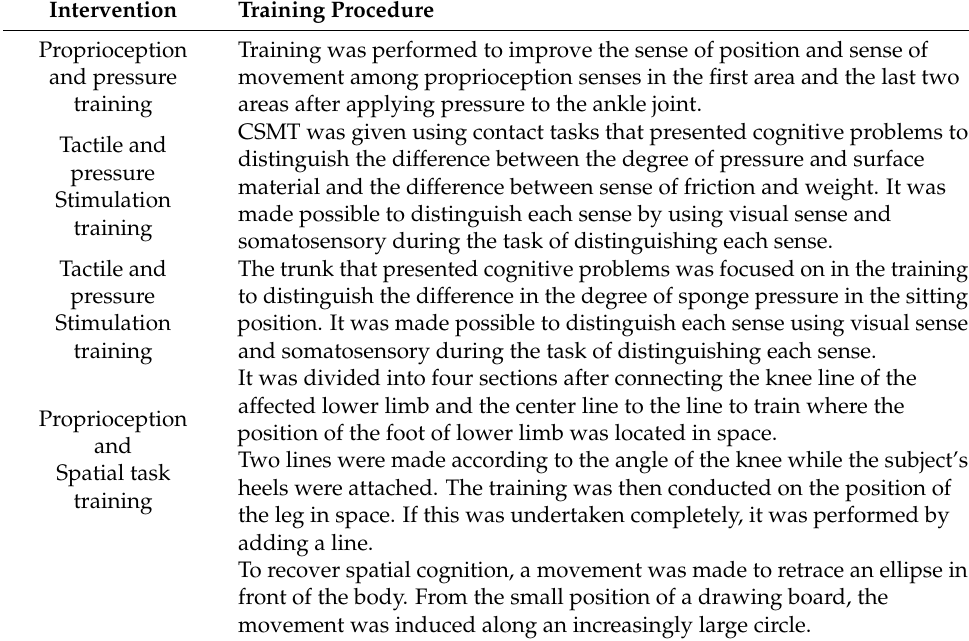
Table 1. Cognitive sensory motor training